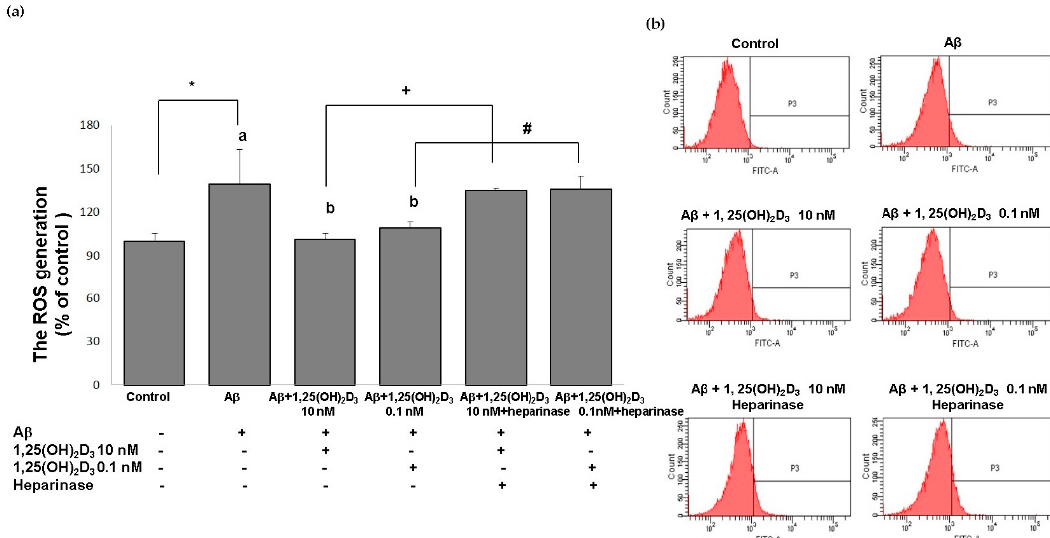
Figure 4. Effects of 1,25(OH) 2 D 3 on A β -induced intracellular reactive oxygen species (ROS) production. ( a ) Quantitative results of ROS levels in each group according to (b). ( b ) Representative profiles of the intracellular ROS levels detected by flow cytometry using the 2’,7’-dichlorofluoroescin diacetate (DCFH-DA) assay. SH-SY5Y cells were incubated with 1 μ M A β (25-35) prior to the addition of 0.1 and 10 nM 1,25(OH) 2 D 3 with or without heparinase III for 24 h. Data are presented as the mean ± SD of three experiments, and each experiment included triplicate repeats. * ,+,# Significantly differs between the two groups (statistical analysis was performed using Student’s t test). Bars of A β , A β + 0.1 nM 1,25(OH) 2 D 3 , and A β + 10 nM 1,25(OH) 2 D 3 with different letters significantly differ ( p < 0.05)